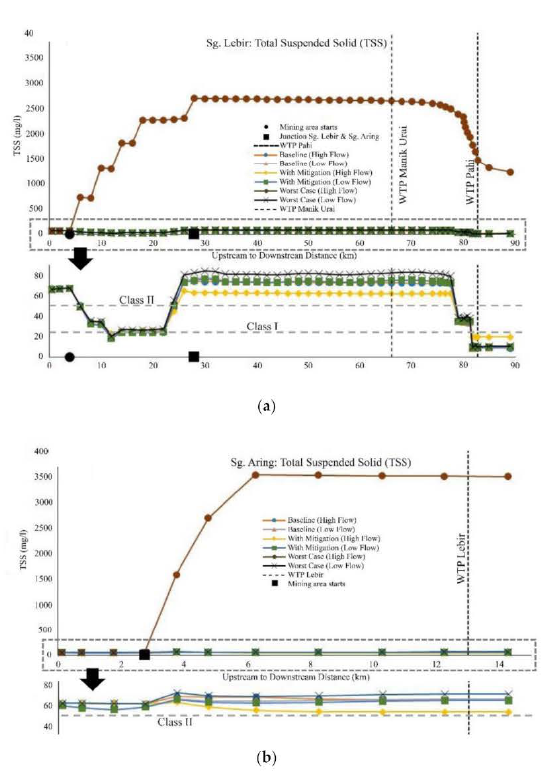
Figure 3. ( a , b ) showing TSS concentrations in different scenarios for Sungai Lebir and Sungai Aring,